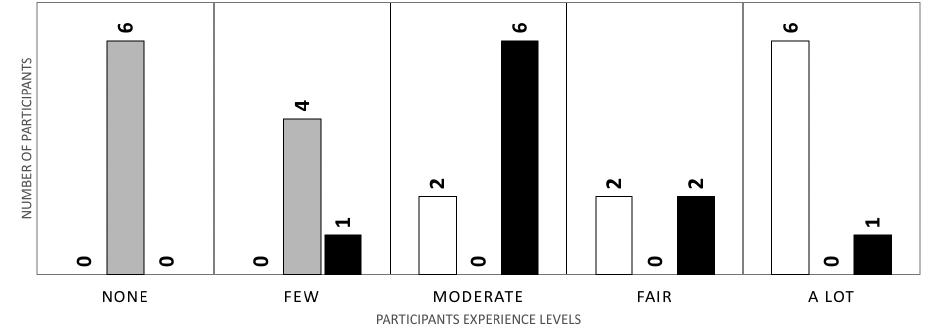
Figure 13. Distribution of participants according to their experience with video games (white bars), eye tracking technology (gray bars), and use of gamepads in FPS games (black